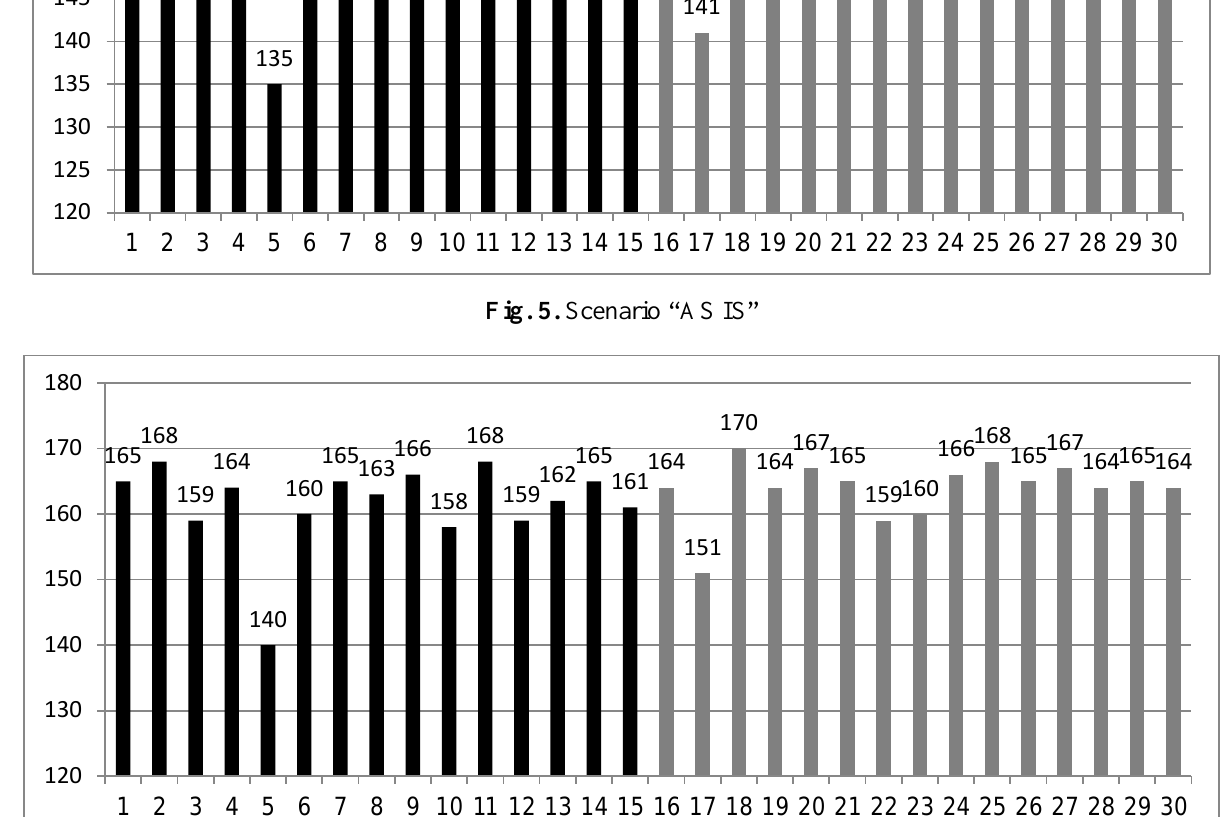
Fig. 6. Scenario “TO BE